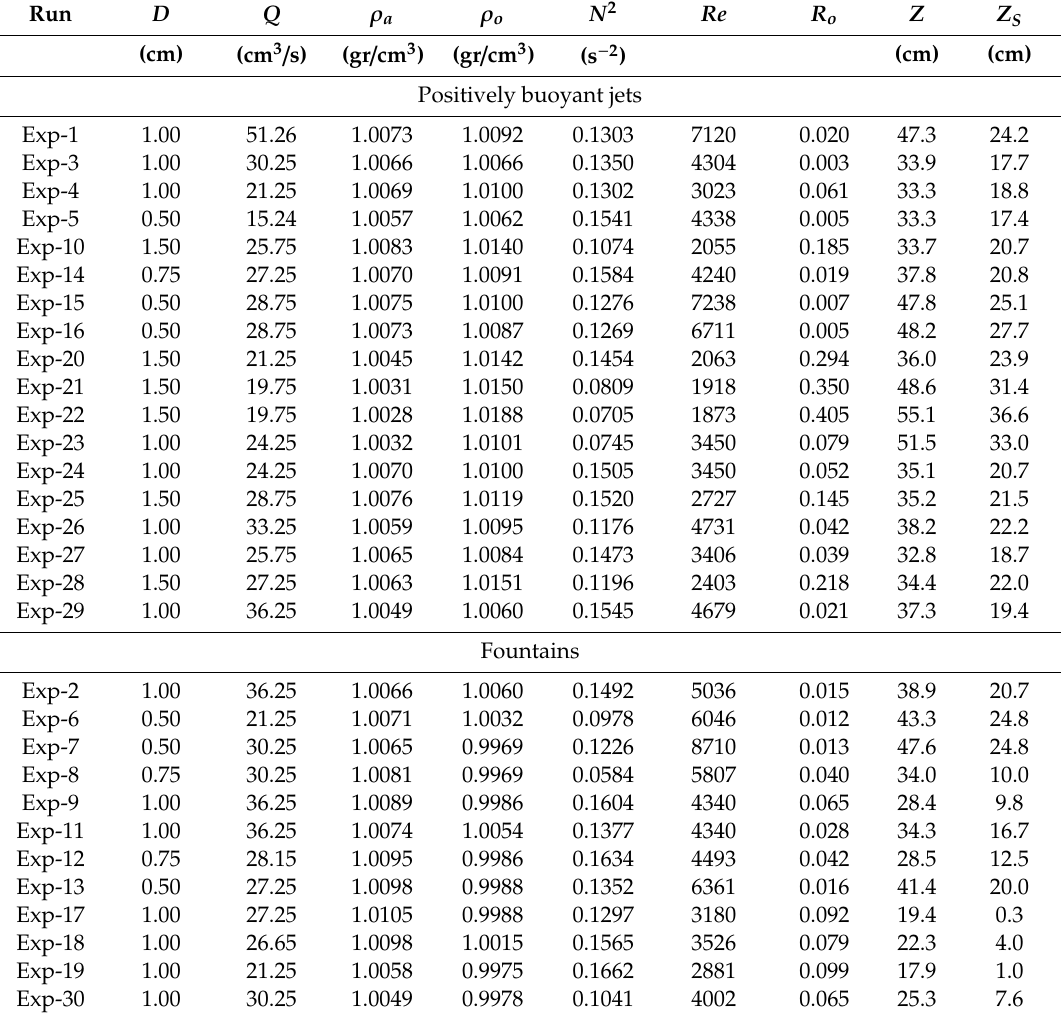
Table 3. Initial flow parameters and measured terminal height of the rise (THR) and spreading height (SH) from positively buoyant jet and fountain experiments